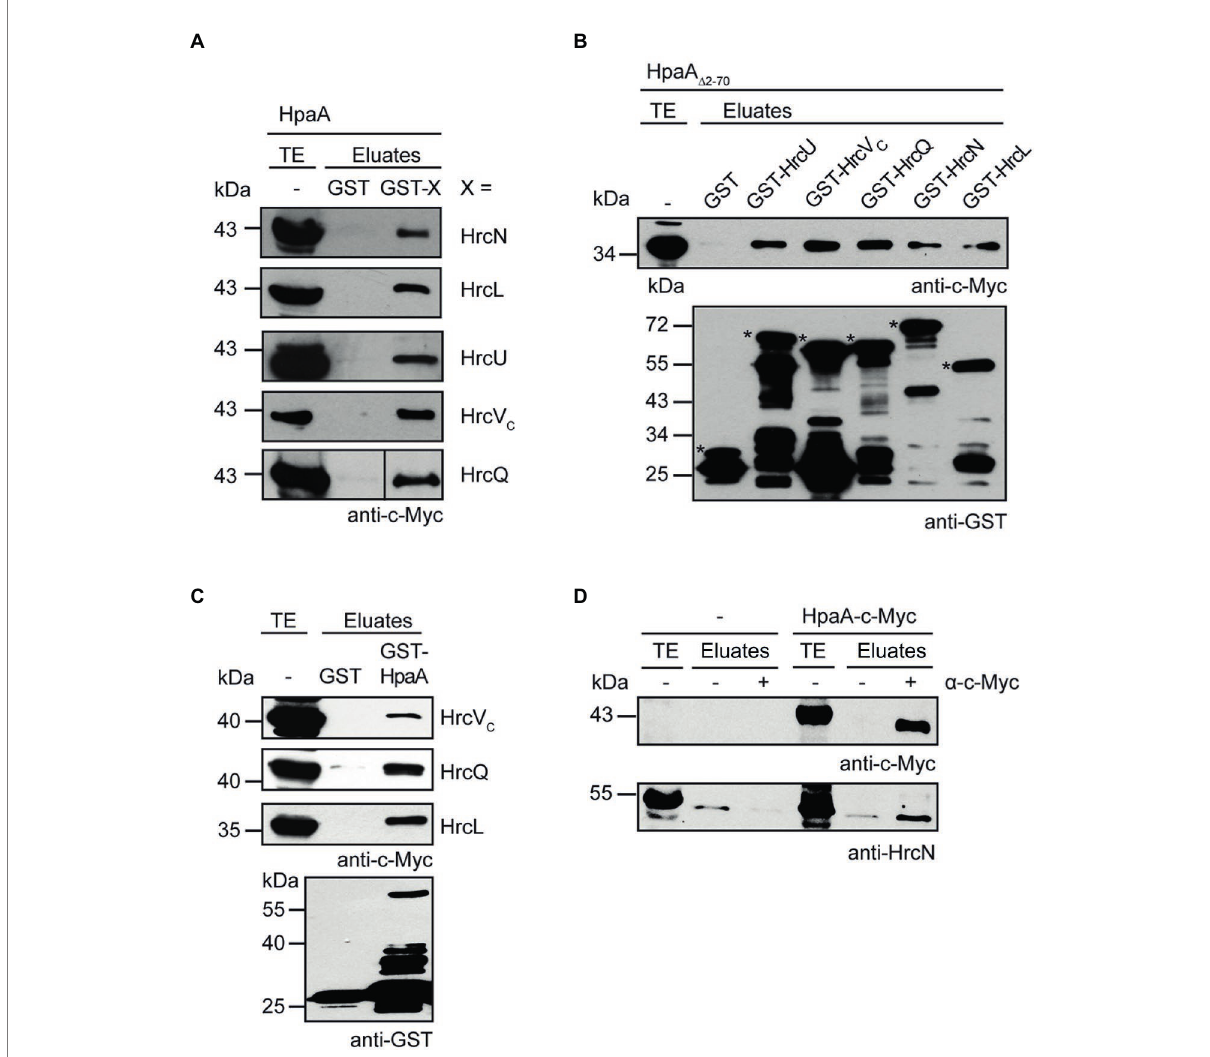
FIGURE 6 HpaA interacts with cytoplasmic components of the T3S system. (A) In vitro interaction studies with HpaA and cytoplasmic components of the T3S system. GST and GST fusions of HrcN, HrcL, HrcU, HrcV C and HrcQ were immobilized on glutathione sepharose and incubated with a bacterial lysate containing HpaA-c-Myc. Total cell extracts (TE) and eluted proteins (eluates) were analysed by immunoblotting using a c-Myc epitope-specific antibody. GST and GST fusions were stably synthesized as is shown in Supplementary Figure S3. (B) The N-terminal region of HpaA is dispensable for the in vitro interaction with cytoplasmic components of the T3S system. GST and GST fusions as described in (A) were immobilized on glutathione sepharose and incubated with a bacterial lysate containing HpaA -c-Myc. TE and eluates were analysed by ∆ 2-70 immunoblotting using c-Myc epitope-and GST-specific antibodies. Asterisks indicate the signals corresponding to GST and GST fusion proteins. Additional signals represent degradation products. (C) GST-HpaA interacts with HrcV C , HrcQ and HrcL. GST and GST-HpaA were immobilized on glutathione sepharose and incubated with bacterial lysates containing HrcV C -c-Myc, HrcQ-c-Myc and HrcL-c-Myc as indicated. TE and eluates were analysed as described in (B) . (D) In vivo interaction studies with HpaA and HrcN. Cell lysates of X. euvesicatoria strain 85* without expression construct ( − ) or encoding HpaA-c-Myc as indicated were incubated in the absence ( − ) or presence (+) of a c-Myc epitope-specific antibody. TE and precipitated proteins (eluates) were analysed by immunoblotting using c-Myc epitope-and HrcN-specific antibodies. The experiment was performed three times with similar